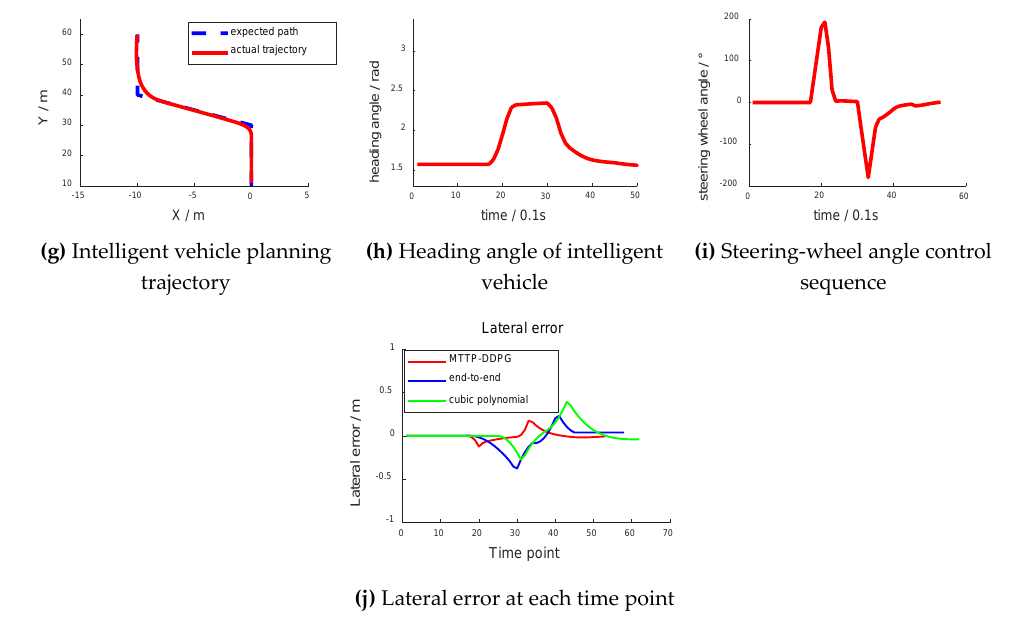
Figure 13. Contrast experiment of S-type ramp scene.